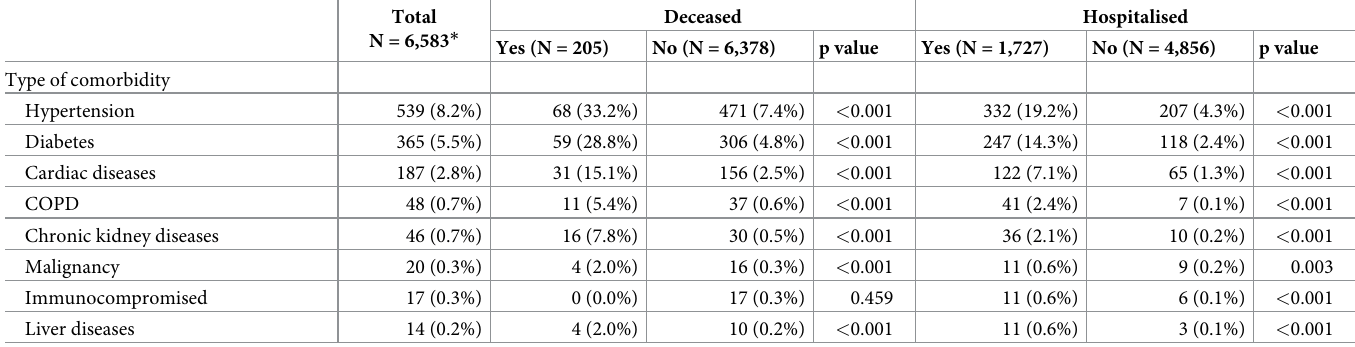
death increased for age groups 50–59 years (aOR 6.5, 95%CI 2.0–21.3), 60–69 years (aOR